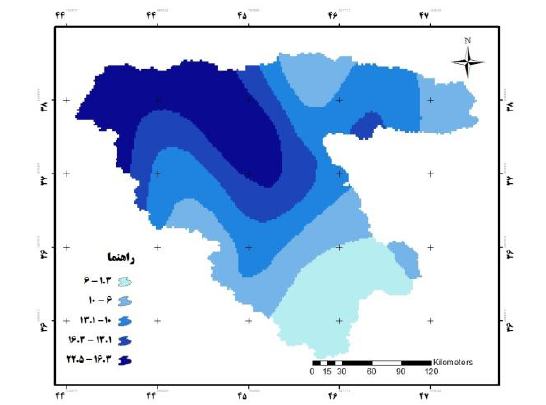
Figure 19: Interpolation of TRMM precipitation data over the catchment basin of Urmia lake (April 22 nd ) However, interpolation of precipitation data for the whole day reflected that the maximum precipitation (i.e. 16.3-22.6) took place over the North-West (26.1%) with decreasing diagonal trend toward South-East, due to entrance or boost of precipitation system from the North West. The maximum rate of precipitation is 22.5 mm which this amount is in conformity with the relative surveyed data. Thus, Urmia Lake is probably located under not cloudy portion of the area.